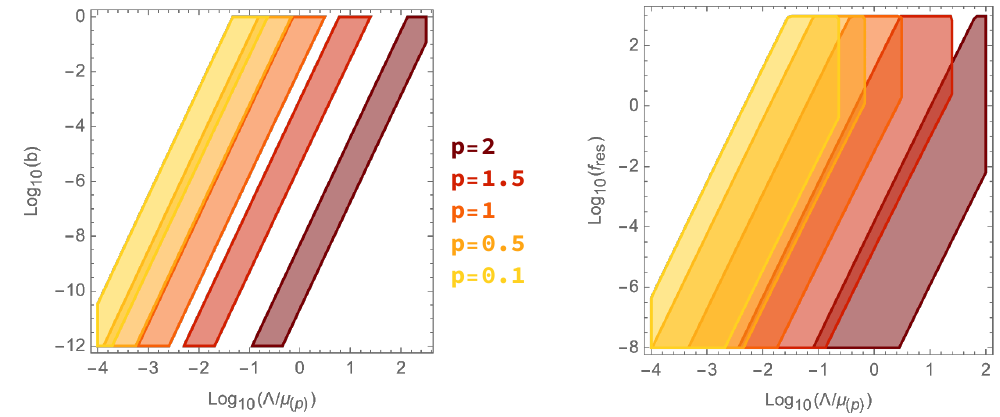
Figure 2. Theoretically allowed values of b ∗ (left) and f res (right) coming from imposing mono- NL tonicity of the inflationary potential, i.e., b ∗ < 1 , FL and WG conjectures, and requiring that ω ∗ < 10 2 to match experimental constraints [44]. These results refer to the monomial monodromy potential in eq. (3.1), fixing the number of e-folding in absence of wiggles to be N = 50 and imposing COBE